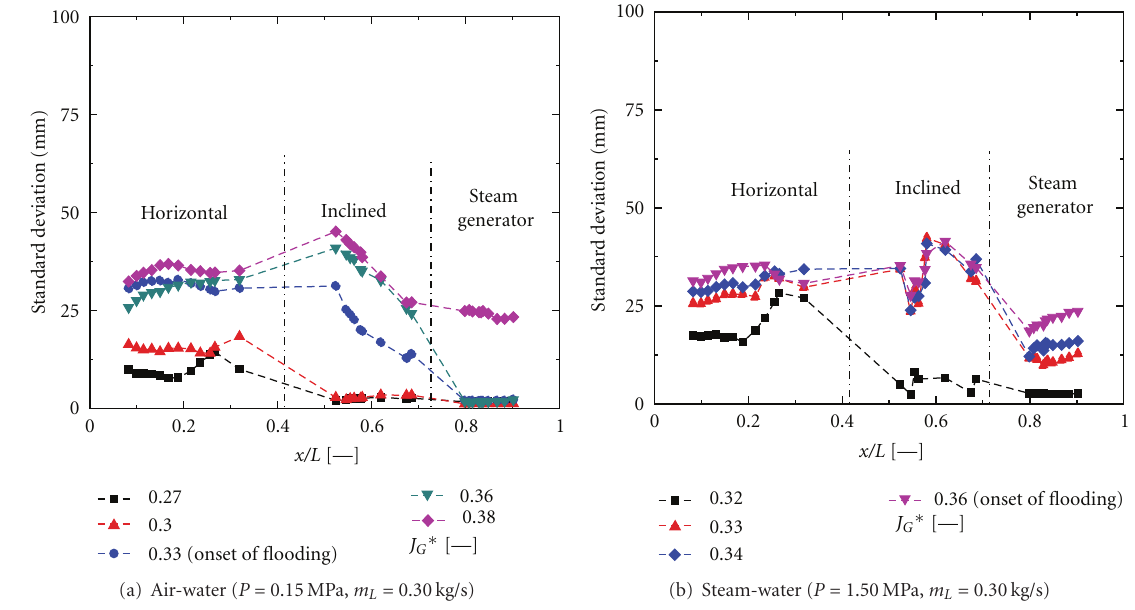
Figure 9: Distribution of the standard deviation of the water level inside the hot leg channel.